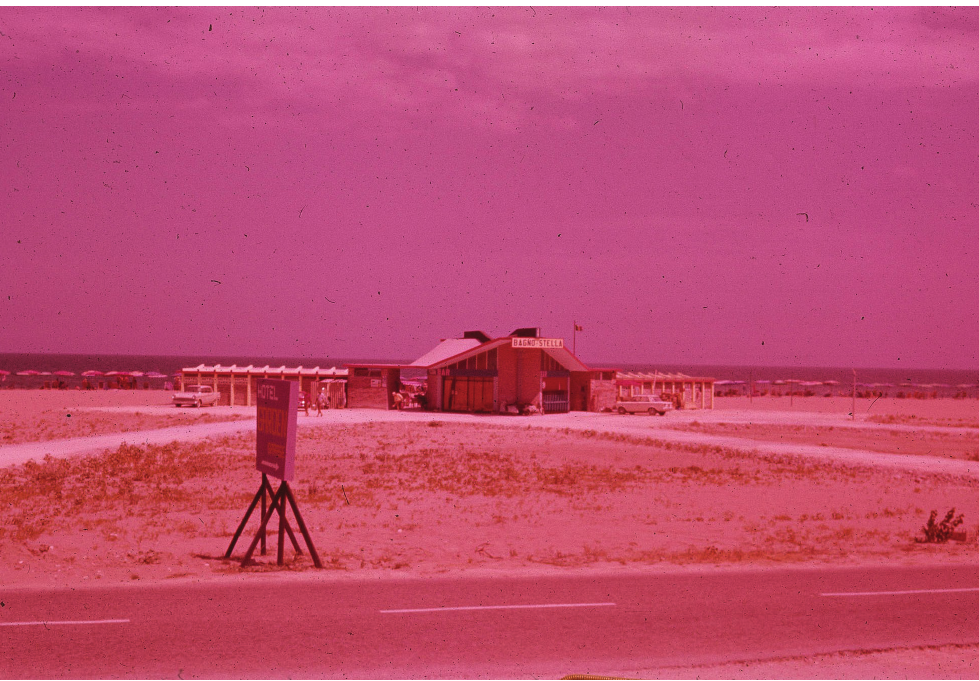
Fig. 3 Clara Sestini, short film using pictures coming from her family photo hoarding (Figures 1, 2). Its frames narrate a new story in which the users can recognize themselves in contents completely far apart from their original contexts,